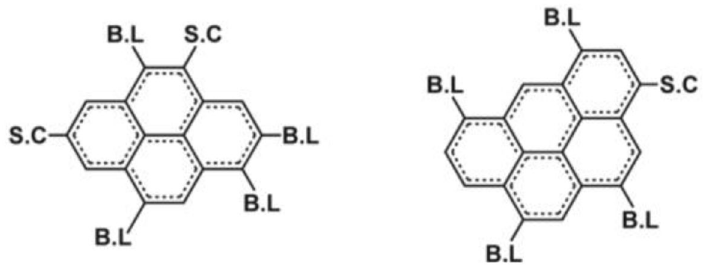
Fig. 5 Representations of the average molecular host size and attachments for vitrinite-rich Waterberg and inertinite-rich Highveld coal. S.C., side chains, B.L. bridges and loops (Van Niekerk et